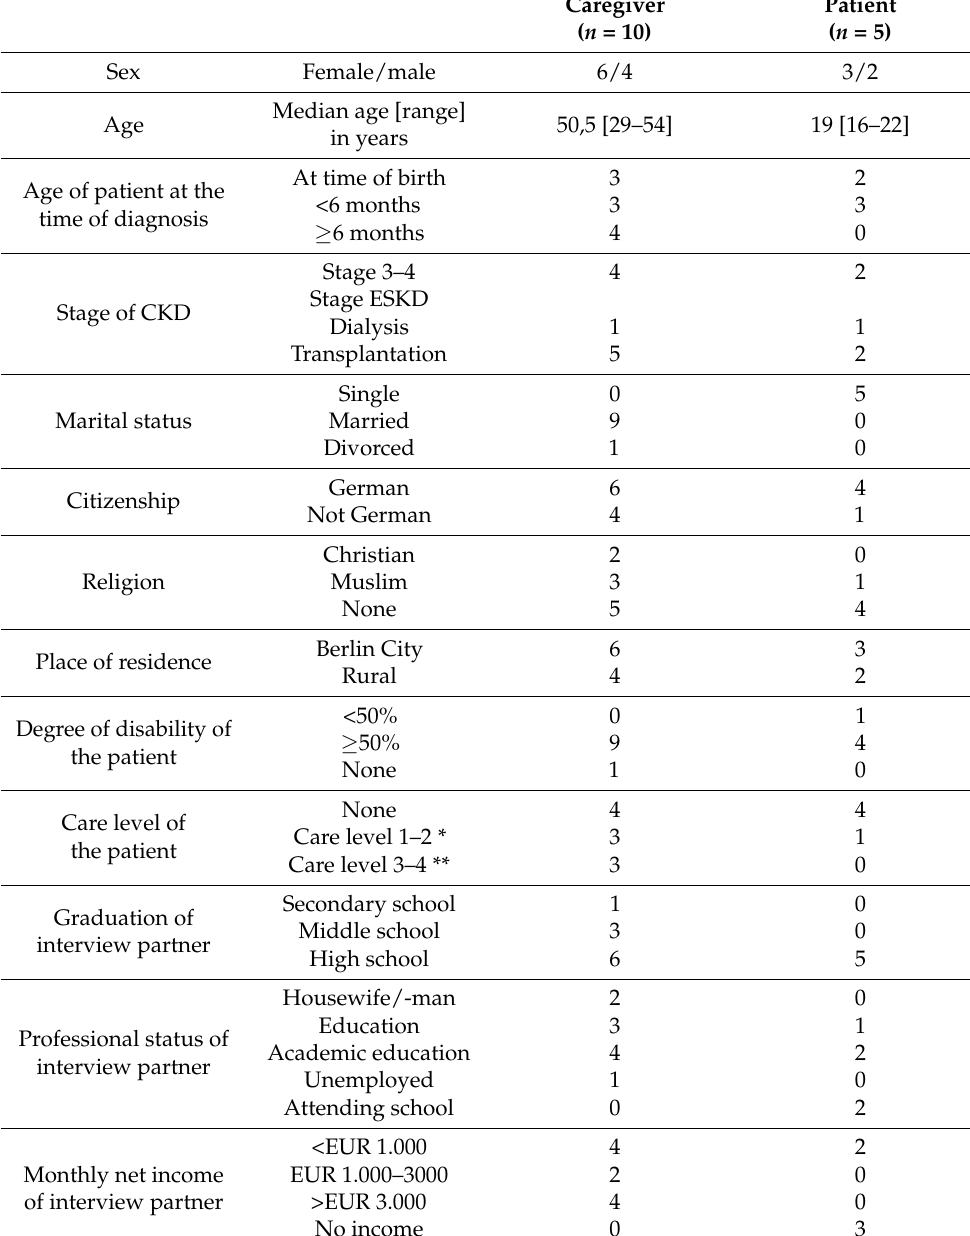
Table 1. Demographic characteristics of the interview